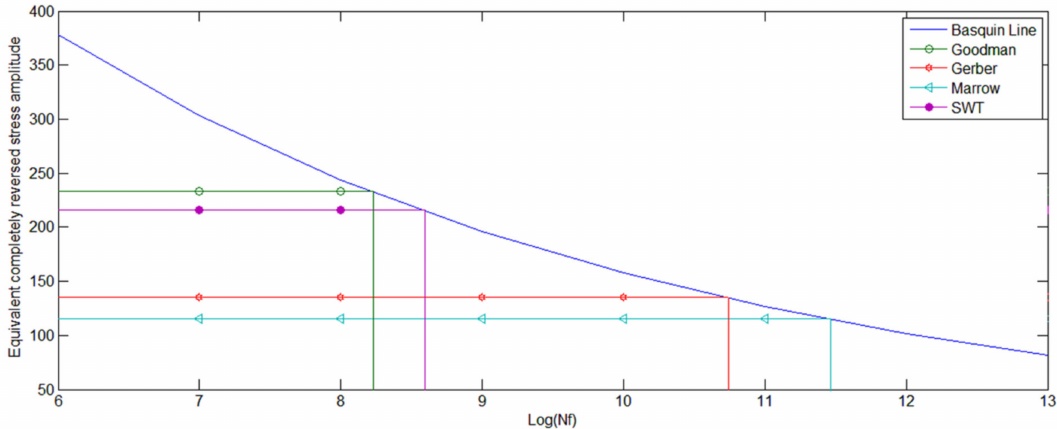
Figure 16. Plot of σ ar (Von Mises)-Log (N f ) for different models describing the